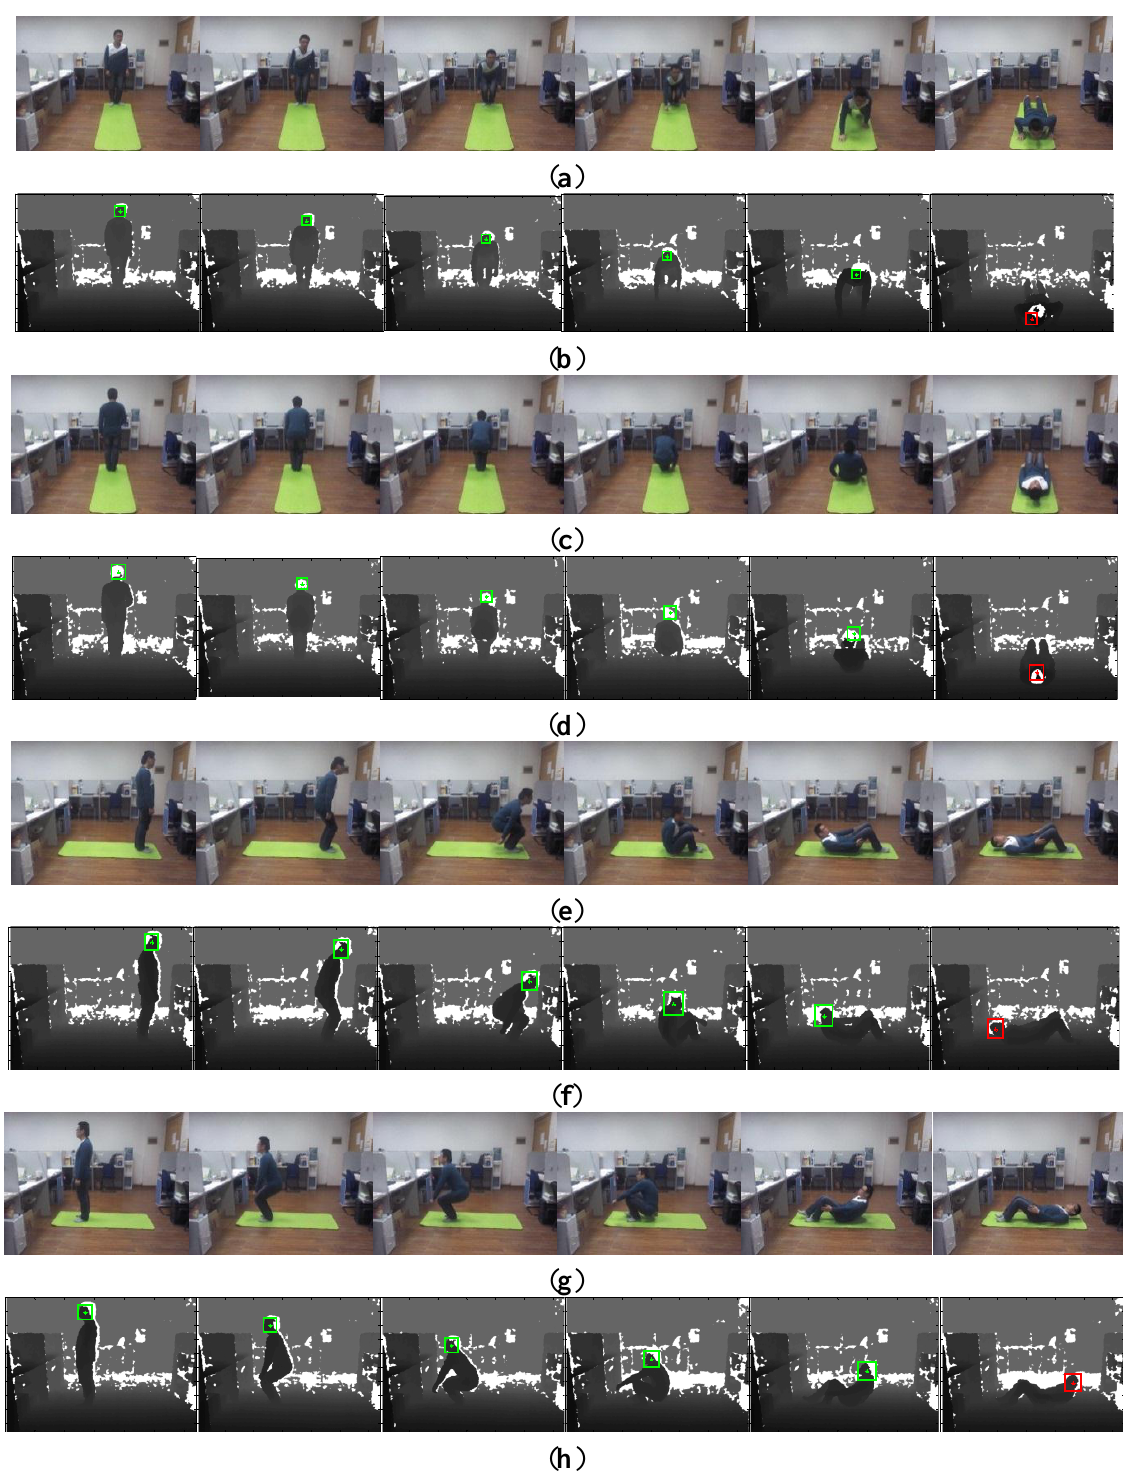
Figure 7. Falling down in different orientations. ( a ) Frames of color images of falling down in the anterior direction; ( b ) frames of depth images of falling down in the anterior direction; ( c ) frames of color images of falling down in the posterior direction; ( d ) frames of depth images of falling down in the posterior direction; ( e ) frames of color images of falling down in left direction; ( f ) frames of depth images of falling down in left direction; ( g ) frames of color images of falling down in right direction; ( h ) frames of depth images of falling down in the right